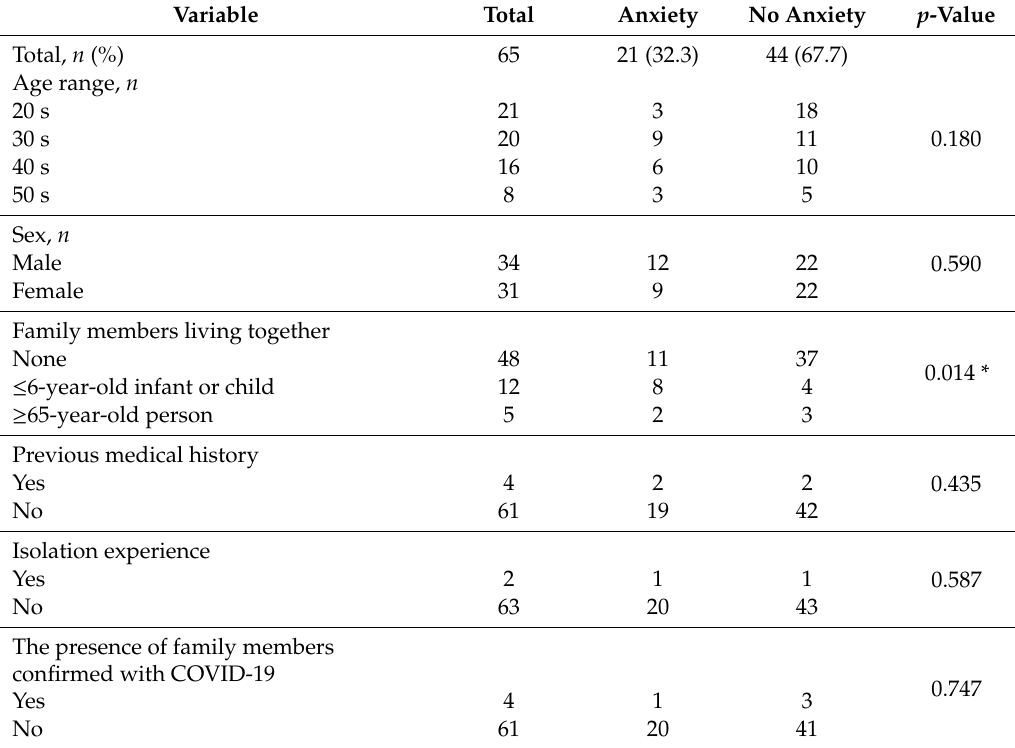
Table 1. Association of demographic data of physical therapists with COVID-19 and the presence of anxiety.